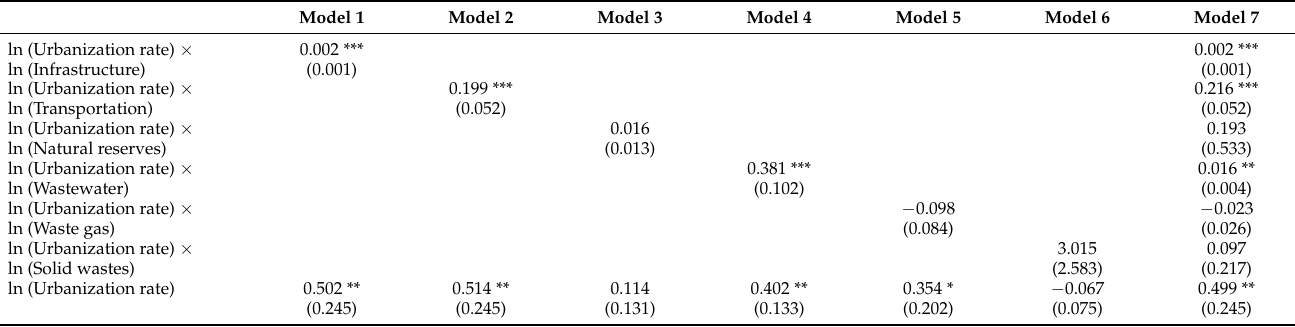
Figure 12. Moderating effect of wastewater. Table 6. Moderating effects of urban environmental factors on the relationship between urbanization and carbon dioxide